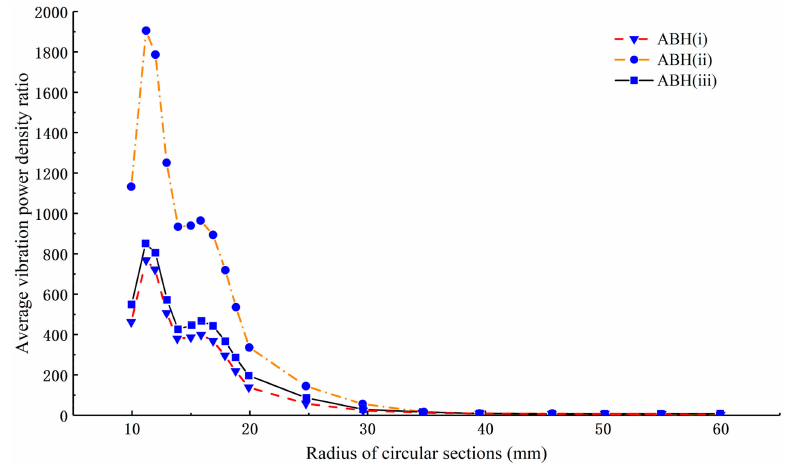
Figure 10. Average vibration power density ratios at excitation frequencies of 1072 Hz.